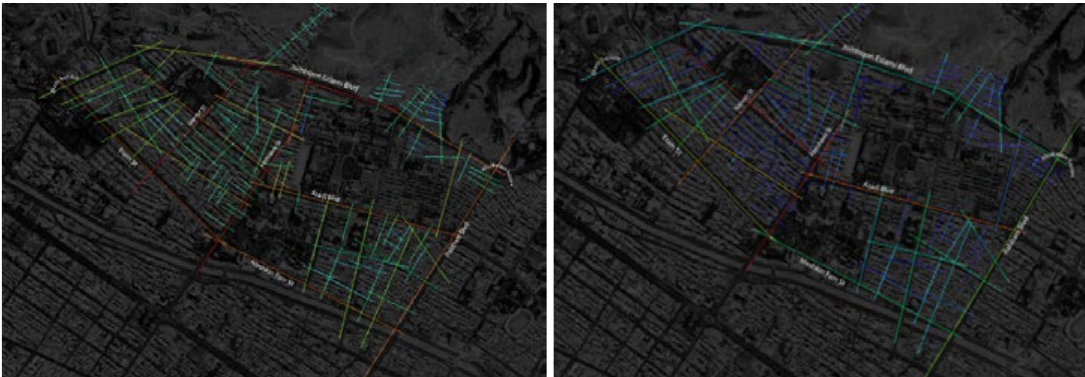
Fig. 9. Space Syntax Maps (Connectivity and Integration) Fig. 10: Designed plan and cross section of Jomhuri street